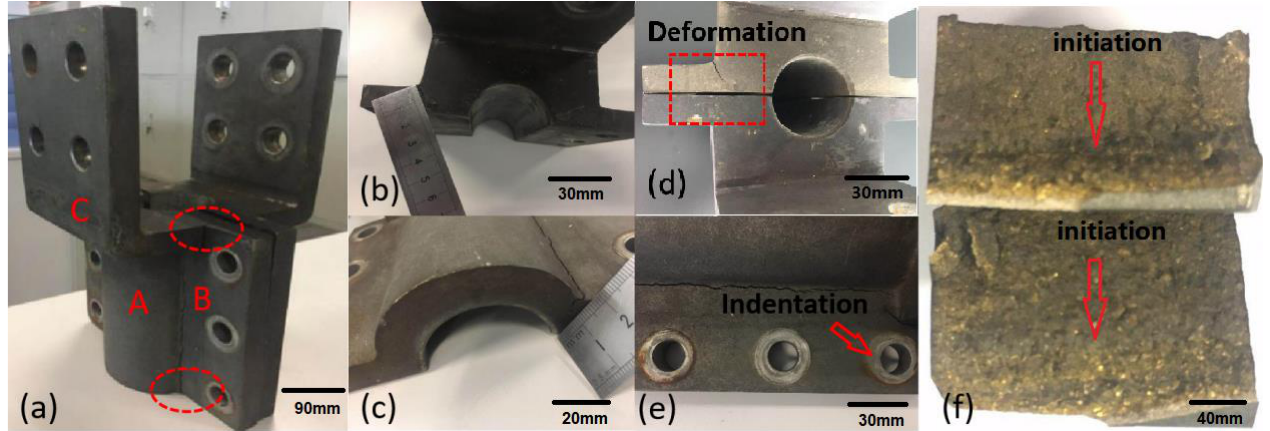
Figure 2. ( a ) Macro-appearance, ( b , c ) crack depth, ( d ) deformation, ( e ) indentation, and ( f ) fracture of the failed clamp.